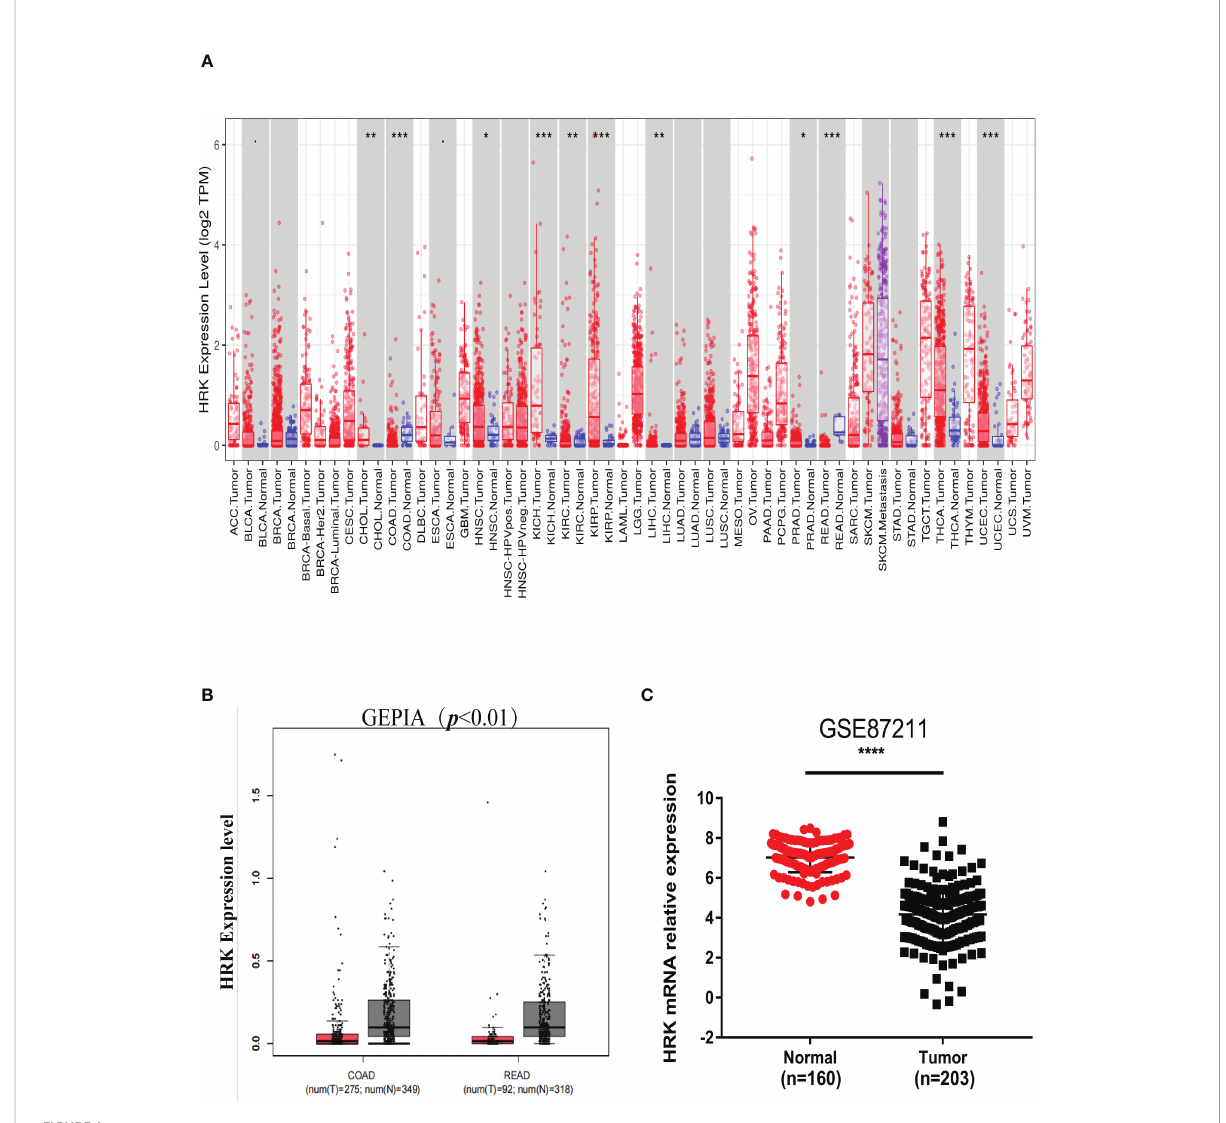
FIGURE 1 HRK expression levels in cancers. (A) , Human HRK expression levels in different types of tumors from TCGA data in TIMER (TCGA, the cancer genome atlas; TIMER, tumor immune estimation resource). (B) , Human HRK expression levels in Rectal adenocarcinoma (READ) and Colon adenocarcinoma (COAD) TCGA data in GEPIA (red bar: tumor, grey bar: normal, P < 0.01). (C) , Expression of HRK mRNA in cancerous and normal tissues in the GSE87211 database. The error bars represent mean ± SD. * P < 0.05, ** P < 0.01, *** P < 0.001 and **** P <